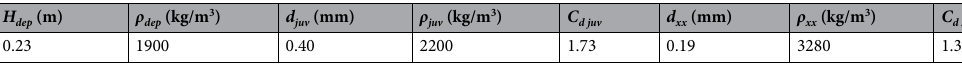
Table 2. Pompeii deposit data used as input in the model.